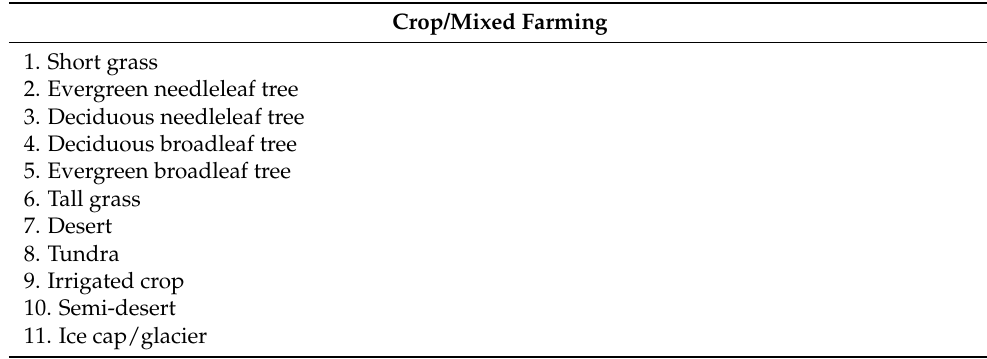
Table 1. Land cover types/vegetation classes used in this study. NB: the values below indicate the type of land cover used in this study which can be found in the legend of Figure